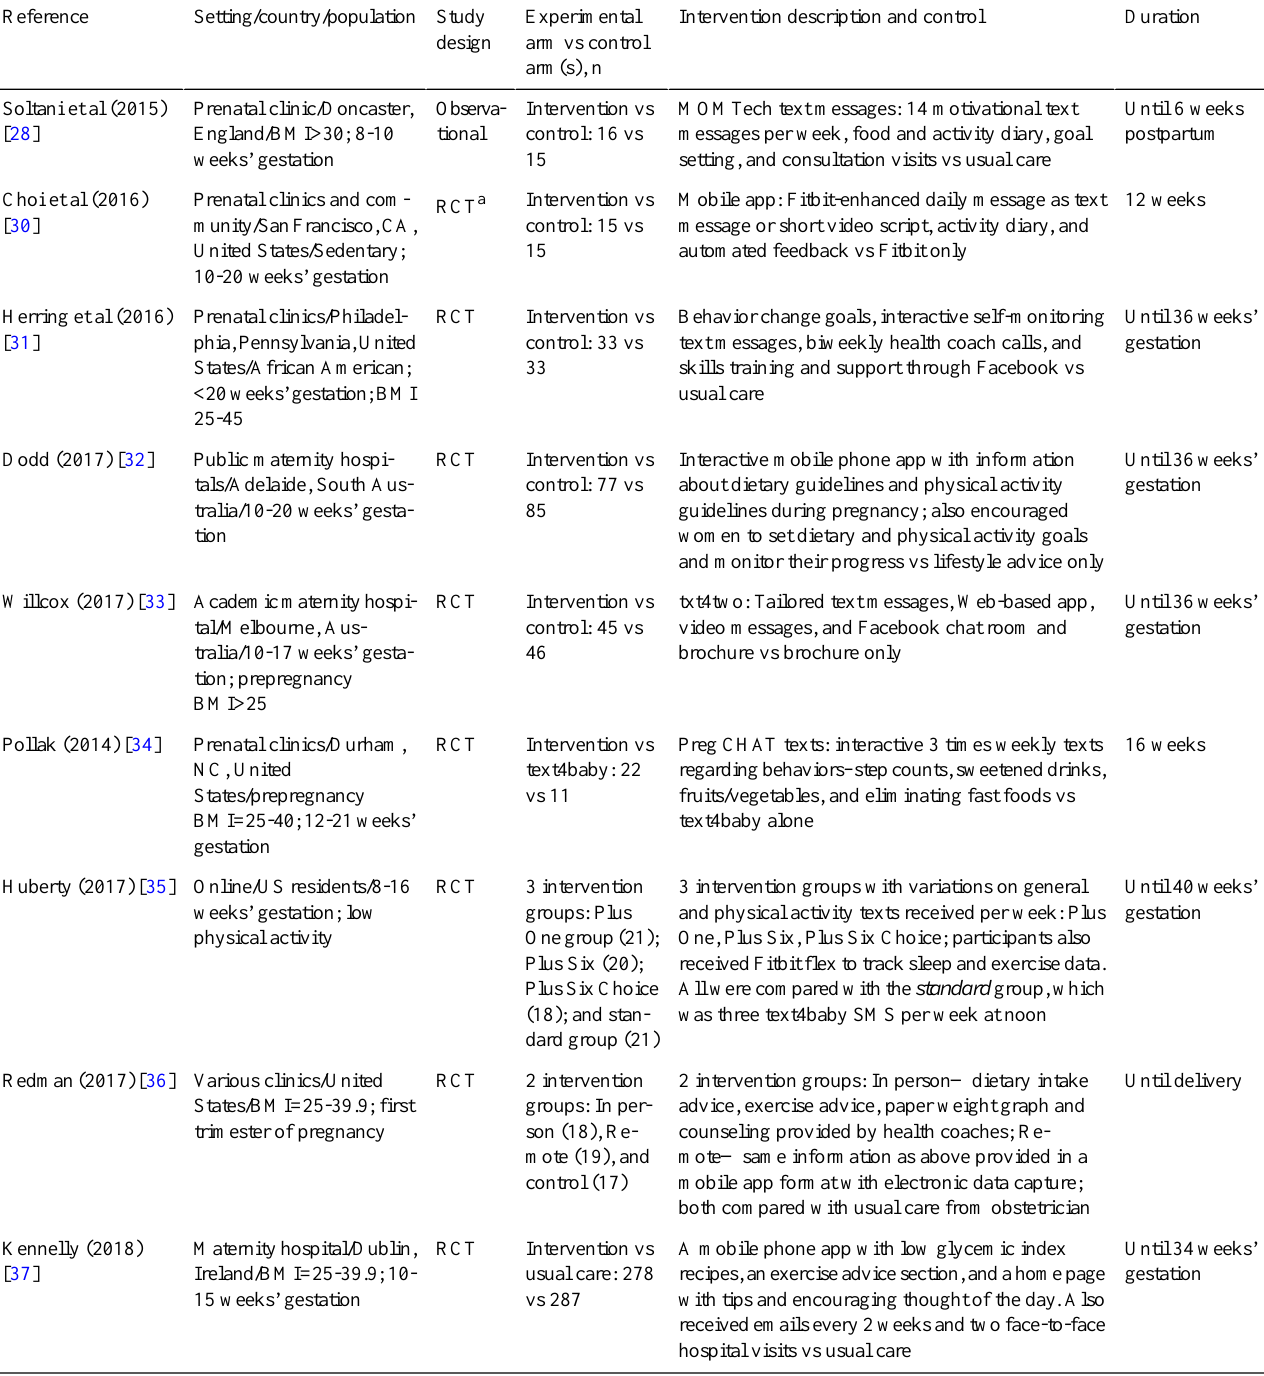
Table 1. Design of trials with a focus on gestational weight gain, obesity, and physical activity.